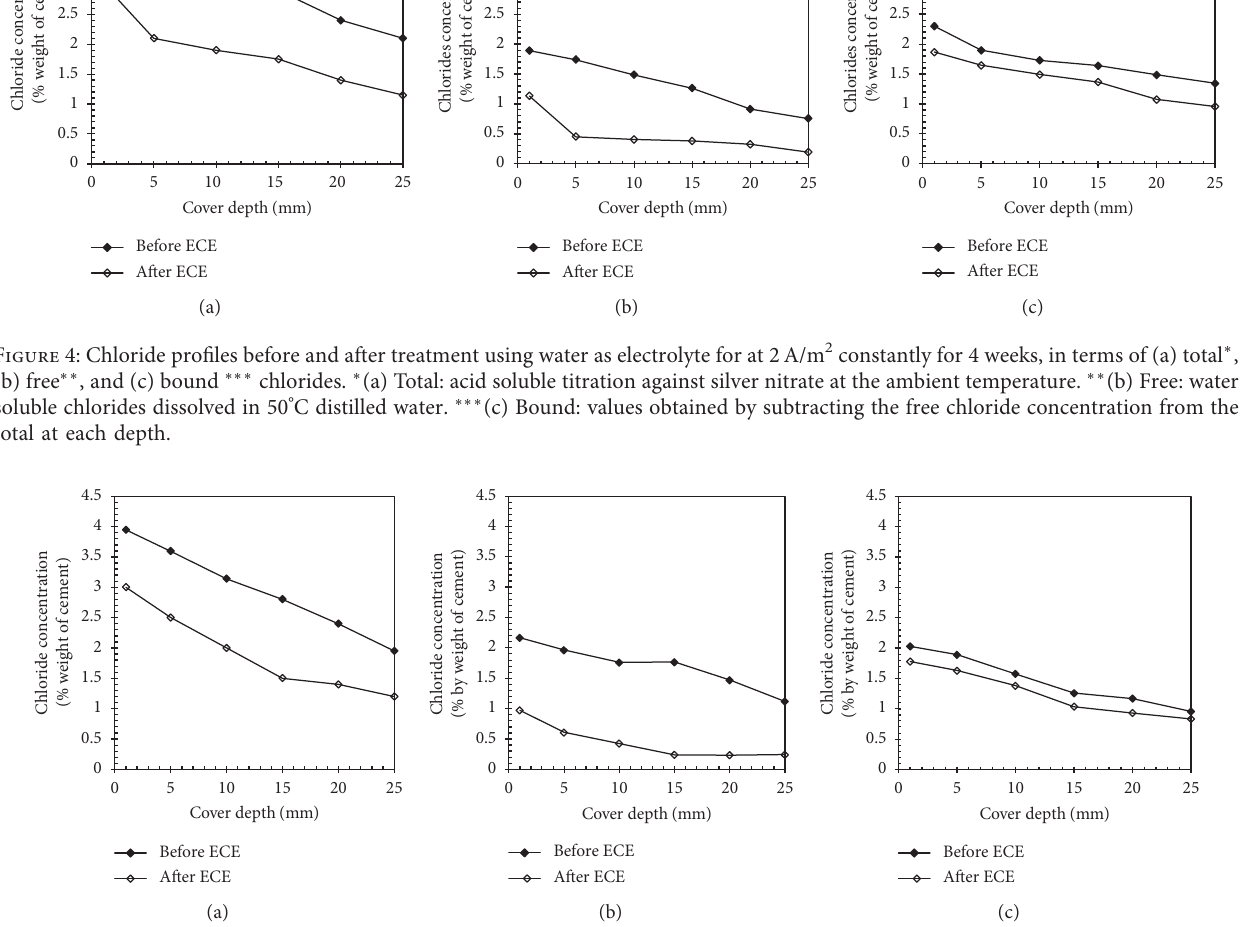
Figure 5: Chloride profiles before and after treatment using calcium hydroxide as electrolyte for at 2A/m 2 constantly for 4 weeks, in terms of (a) total ∗ , (b) free ∗∗ , and (c) bound ∗∗∗ chlorides. ∗ (a) Total: acid soluble titration against silver nitrate at the ambient temperature ∗∗ (b) Free: water soluble chlorides dissolved in 50 ° C distilled water ∗∗∗ (c) Bound: values obtained by subtracting the free chloride concentration from the total at each